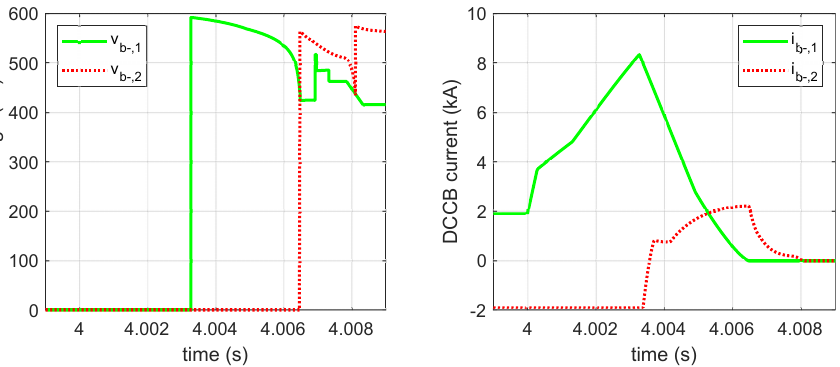
Figure 15. Voltage and current of the lower DC circuit-breakers during DC pole-to-pole fault.